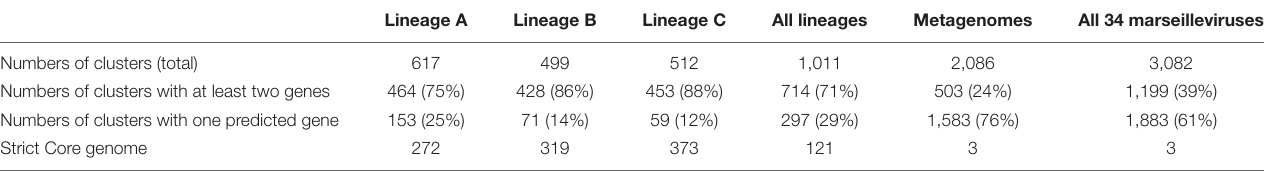
TABLE 1 | Pangenome and core genome size descriptions for marseilleviruses of lineage A to C and all viruses